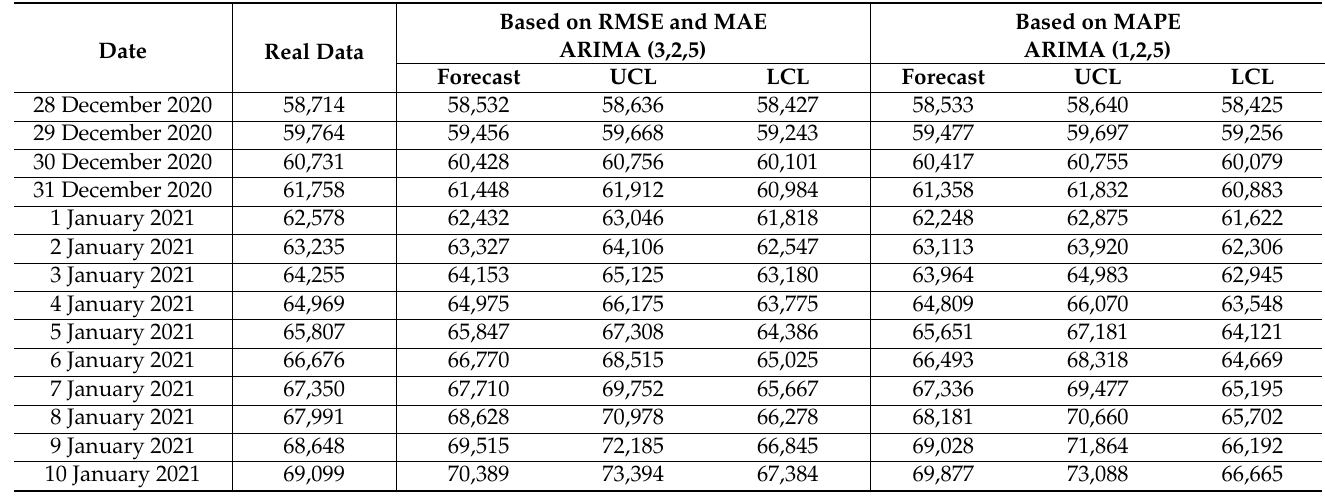
Table 10. Prediction of cumulative confirmed cases according to the best models with 95% confidence interval.